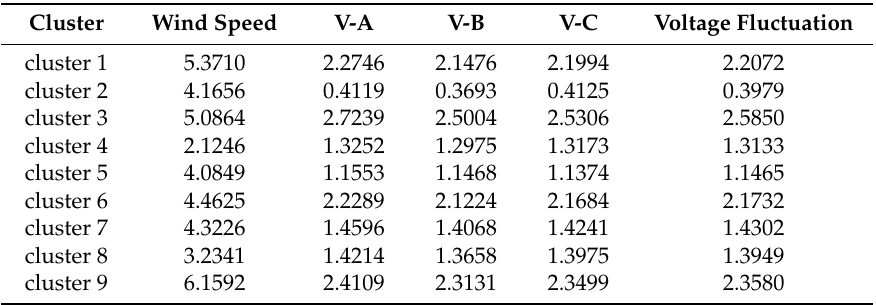
Table 9. Cluster center (k = 9).